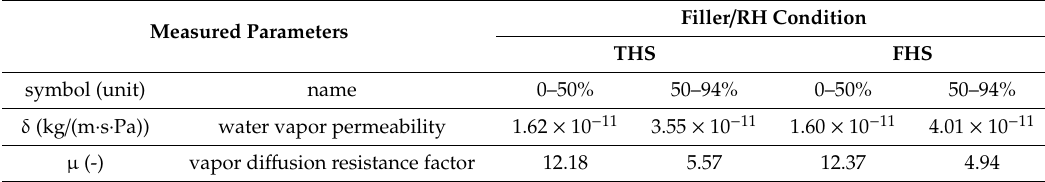
Table 5. Vapor permeability results.